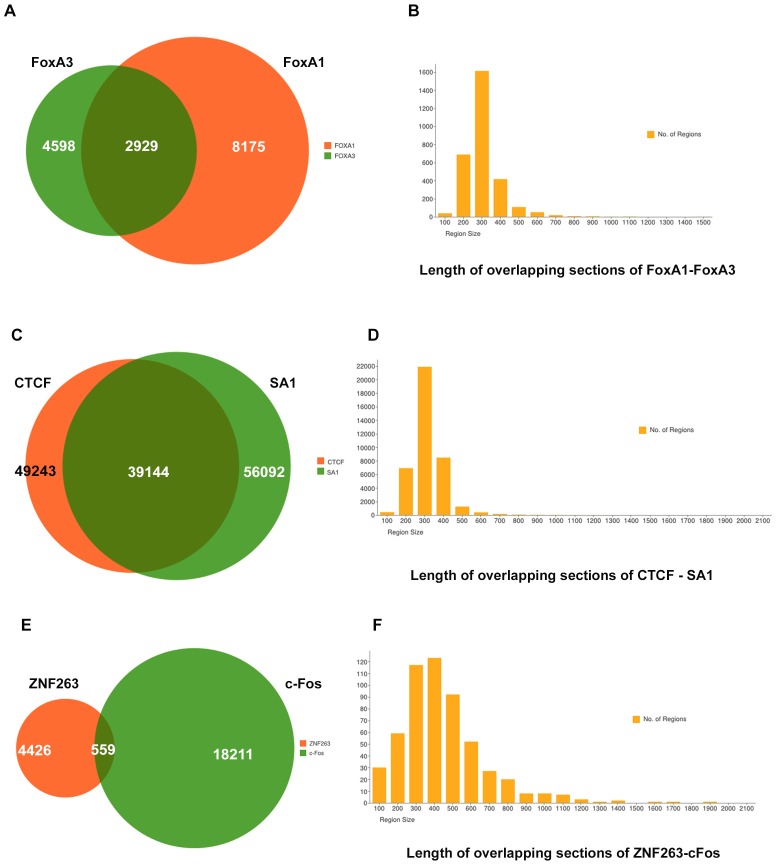
Example study of overlap between FoxA1 and FoxA3, CTCF and SA1, ZNF263 and c-Fos datasets.A) Venn diagram representation of 2,929 overlapping regions in FoxA1 (8,175 regions) and FoxA3 (4,598 regions) datasets. B) Common sections of overlapping regions are saved back into the KB, and for bin size 100 a histogram of the size distribution of region overlaps is drawn. The histogram shows that there are more than 1,600 regions that have at least ∼300 bp in common between the two datasets. C) Overlap of 39,144 regions between CTCF and SA1 datasets. D) Distribution of overlapping sections of CTCF and SA1. E) Overlap of 559 regions between ZNF263 and c-Fos datasets. D) Distribution of overlapping sections of ZNF263 and c-Fos. We also observed that in three comparisons >94% of the overlapping sections are >200 bases long, suggesting that overlapping regions usually share a significant section of the two sets.